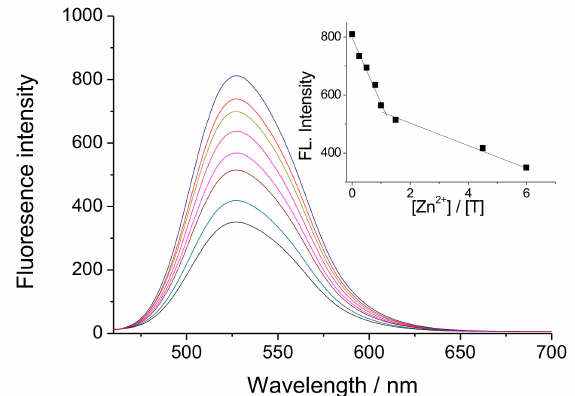
Figure 1. Fluorescence spectra of BT (c = 1 × 10 − 5 M) at di ff erent concentrations of Zn(II) ions (c = 0–6 × 10 − 5 M). The inset shows the quenching of the fluorescence intensity on Zn(II) concentrations.